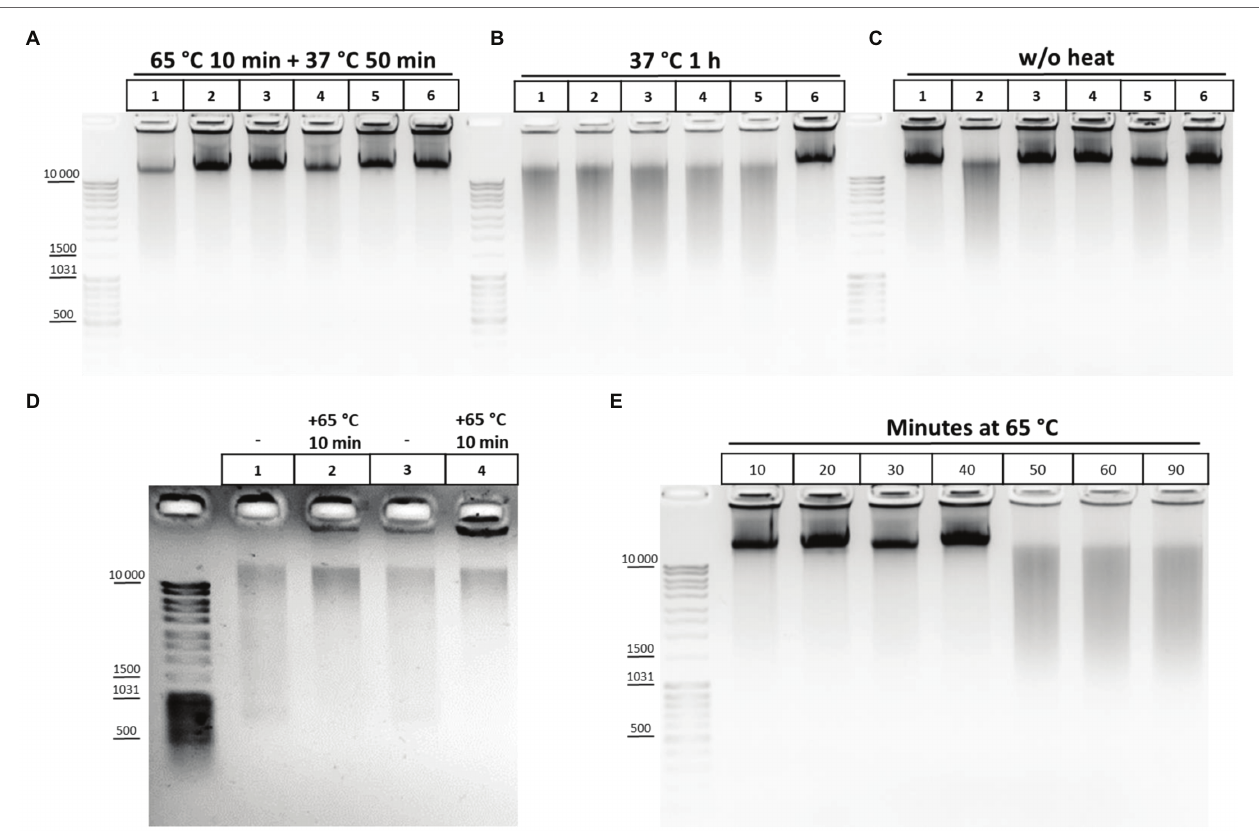
FIGURE 2 | Cell lysis buffer composition and temperature regimens of chromatin treatment affect DNA integrity. (A-C) Effect of the lysis buffer composition on the integrity of the resulting DNA. 10 mg (~12 mln of cells) of S2 cells was fixed with 1% FA in 1X PBS at RT for 10 min, quenched equimolar with glycine for 5 min at RT, washed twice with 1X ice-cold PBS, and then resuspended in ice-cold lysis buffers #1, 2, 3, 9, 10, and 11 according to Table 2 . Lane 1 – Buffer #1; Lane 2, #2; Lane 3, #3; Lane 4, #9; Lane 5, #10; and Lane 6, #11. Cells were incubated in different lysis buffers on ice for 15 min and were then washed once with ice-cold 1X PBS and resuspended in 1X RB for DpnII (50 mM Bis-Tris-HCl, 100 mM NaCl, 10 mM MgCl 2 , 1 mM DTT, and pH 6.0 at 25 ° C). Then, SDS was added up to 0.1% (A,B) and the nuclei were treated with heat at 65 ° C for 10 min + 37 ° C for 50 min (A) or at 37 ° C for 1 h (B) and then Triton X-100 was added up to 1.8% (A,B) and the nuclei were incubated at 37 ° C for 1 h (A,B) . Thereafter, 500 μ l of EB (50 mM Tris-HCl pH 8.0, 50 mM NaCl, and 1% SDS; Hug et al., 2017) containing 30 mM EDTA and 0.2 mg/ml PrK was added. The cross-links were reversed in EB at 65 ° C overnight (O/N) and the DNA was extracted with Ph/Chl and subsequently with Chl only, precipitated with 3 V of 96% ethanol, 0.3 M NaOAc pH 5.2, and 100 μ g of glycogen, washed with 70% ethanol three times, dissolved in 25 μ l of 10 mM Tris-HCl pH 8.0, and treated with 0.2–0.4 mg/ml of bovine RNase A for 30 min at RT. The amount of DNA subjected to electrophoresis was 1 μ l. For (C) , the cells were treated in the same way as for A and B , but the step of chromatin heat treatment in the presence of SDS and Triton X-100 was omitted and instead, immediately after resuspension of nuclei in 1X RB, 500 μ l of EB was added, supplemented with the same amount of SDS and Triton X-100 as for A and B . The reversion of cross-links and DNA extraction was performed in the same way. One of the three replicate experiments is shown. (D) Chromatin heat treatment at 65 ° C results in some DNA preservation during subsequent isolation. С ells were fixed, quenched, washed after quenching with 1X PBS as in A - C, and lysed in isotonic lysis buffer #3 (see Table 2 ; Tolhuis et al., 2002; lanes 1, 2) or in hypotonic lysis buffer #10 (Splinter et al., 2012; van de Werken et al., 2012; lanes 3, 4). Cells were incubated in lysis buffers on ice for 15 min and then nuclei were centrifuged, supernatant was discarded, nuclei were resuspended in 1X RB, SDS was added up to 0.3%, and nuclei were incubated at 65 ° C for 10 min (lanes 2, 4) or left untreated (lanes 1, 3). Thereafter, 500 μ l of EB was added, the cross-links were reversed as in A - C , and the DNA was extracted using the GeneJET Genomic DNA purification kit (Thermo), according to the manufacturer’s instructions. (E) DNA degradation upon chromatin treatment at 65 ° C. С ells were fixed, quenched, washed after quenching with 1X PBS as in A - C , and then lysed in isotonic lysis buffer #3 (see Table 2 ). Cells were incubated in lysis buffer on ice for 15 min and then nuclei were washed once with 1X ice-cold PBS, resuspended in 1X RB for DpnII, and then SDS was added up to 0.1%. Then, nuclei were treated with heat at 65 ° C for 10, 20, 30, 40, 50, 60, and 90 min in the presence of 0.1% SDS. After that, the nuclei were incubated for up to 1 h at 37 ° C for 50, 40, 30, 20, and 10 min (lanes 1–6, respectively). Then, Triton X-100 was added up to 1.8% and the nuclei were incubated at 37 ° C for 1 h. In the case of lane 7, after incubation in 0.1% SDS at 65 ° C for 90 min, Triton X-100 was added immediately up to 1.8% and nuclei were incubated at 37 ° C for 1 h. After incubation with SDS/Triton X-100500 μ l of EB was added to all samples, the cross-links were reversed and the DNA was extracted, precipitated, dissolved, and treated with bovine RNase A and subjected to electrophoresis as in A - C . One of the three replicate experiments is